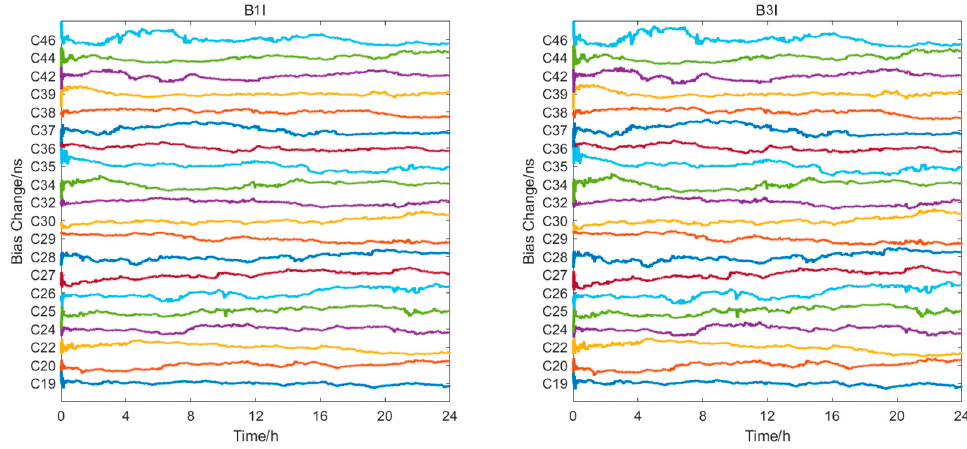
Figure 4. Time series of the observable-specific signal bias at E1 and E5a frequencies of the Galileo for DOY 301, 2021.